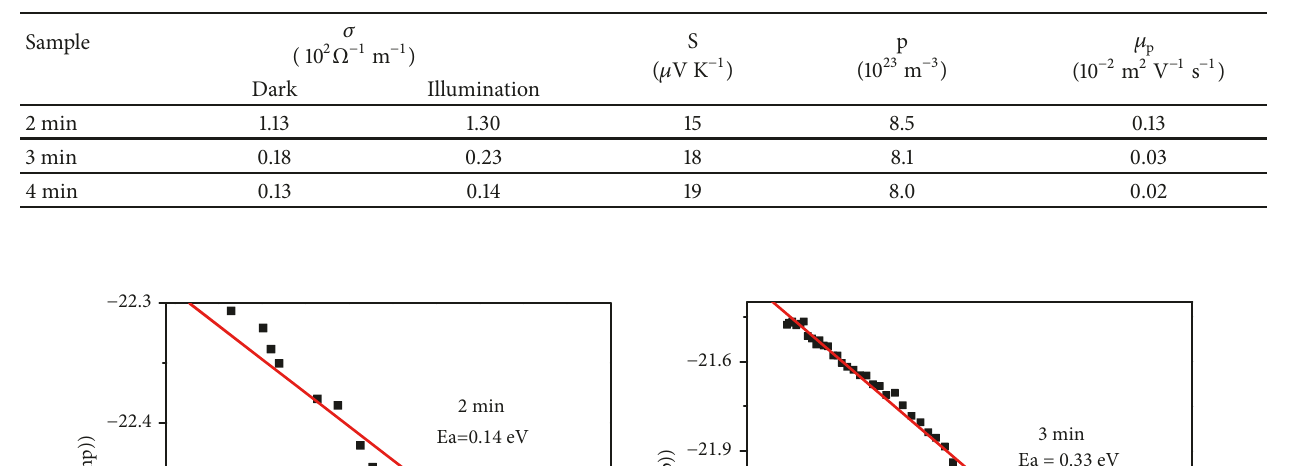
Table 3: Electrical parameters of PbS thin films.